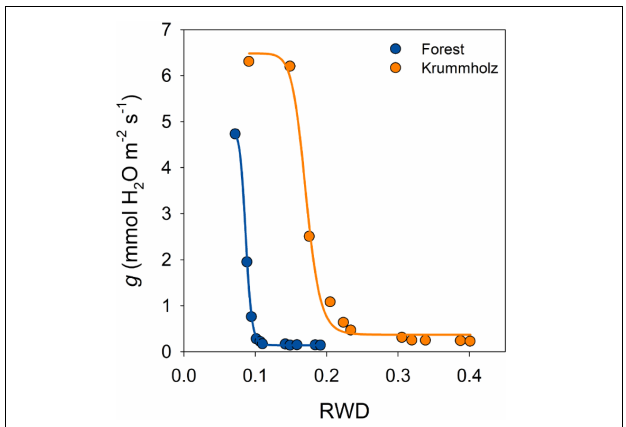
FIGURE 3 | Cuticular water conductance ( g ) as a function of the relative water deficit (RWD) for a single representative tree of each one of the studied populations of P. uncinata (Forest and Krummholz). A sigmoidal four-parameter curve is fitted to guide the eye. The transition between the declining stage and the plateau stage of needle conductance represents stomatal closure. After maximum stomatal closure, needle conductance remains constant, representing the minimum needle conductance ( g min ).